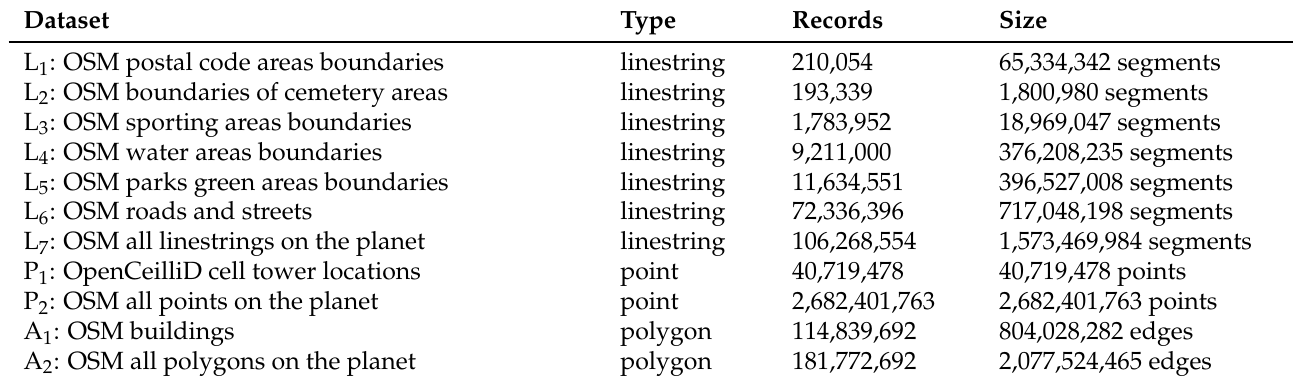
Table 2. Datasets used in the